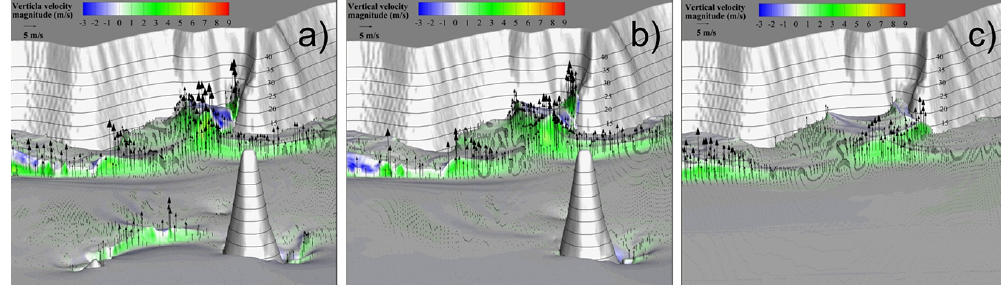
Figure 11. Instantaneous vertical velocities computed at t = 240s (a) with two islands, (b) with one island and (c) without